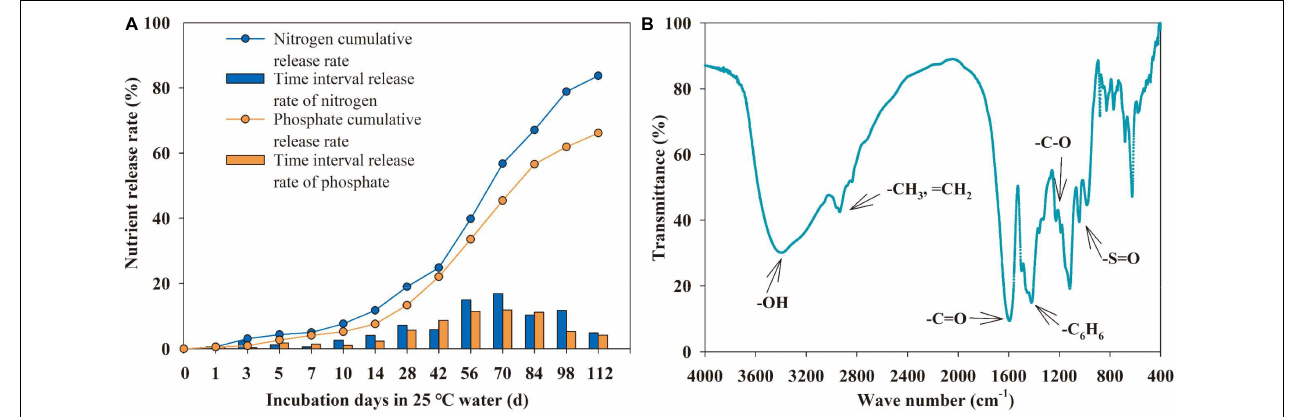
FIGURE 1 | Release rates and accumulative release rates of nutrient from coated diammonium phosphate (CDAP) in 25 ◦ C water (A) ; infrared spectrogram of humic acid (HA) (B) .